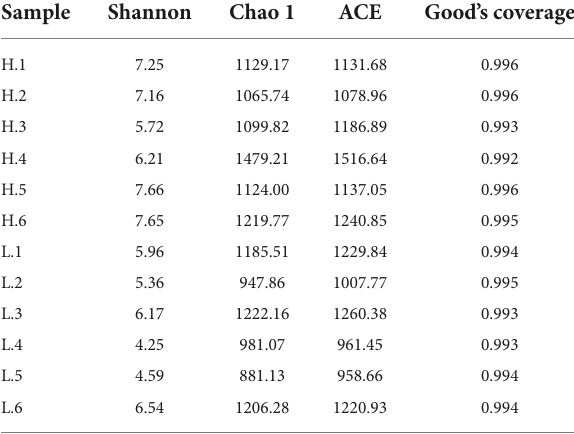
TABLE 2 The alpha diversity index of each